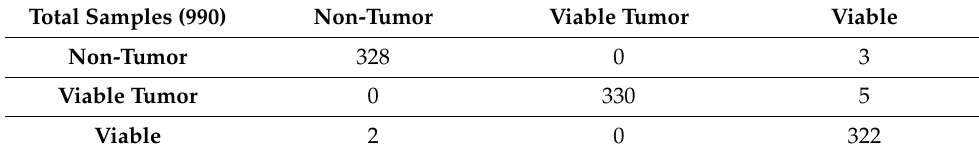
Table 3. Testing confusion matrix of SGDM empowered with transfer learning. Total Samples (990)